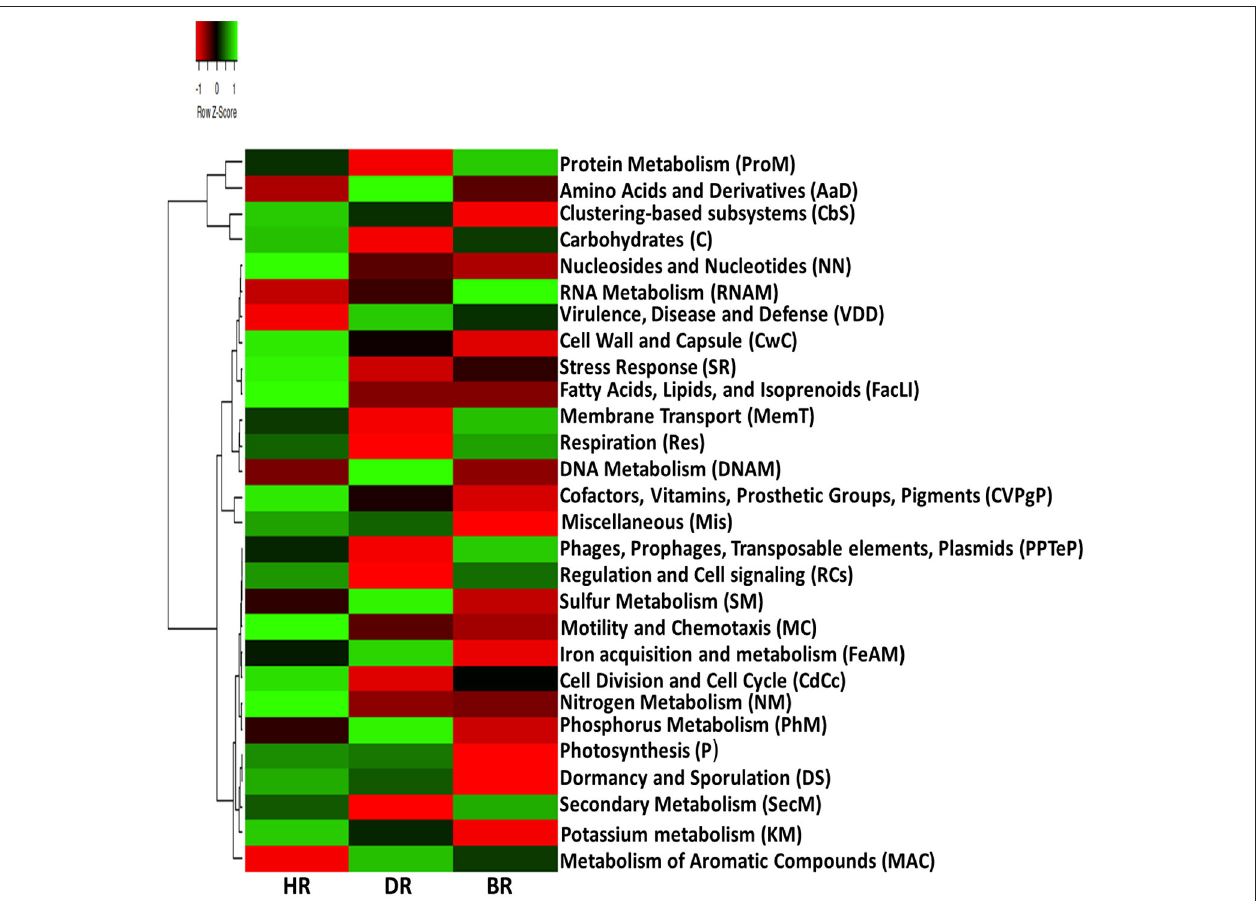
FIGURE 1 | Heatmap data of primary metabolism of the microbiomes in the healthy, diseased rhizosphere soil of tomato plants and bulk soil samples at Level 1. Each plot situated on the relative abundances expresses the gradient color with a Z -score. HR, soil obtained from healthy tomato rhizosphere; DR, rhizosphere soil from diseased tomato; BR, bulk